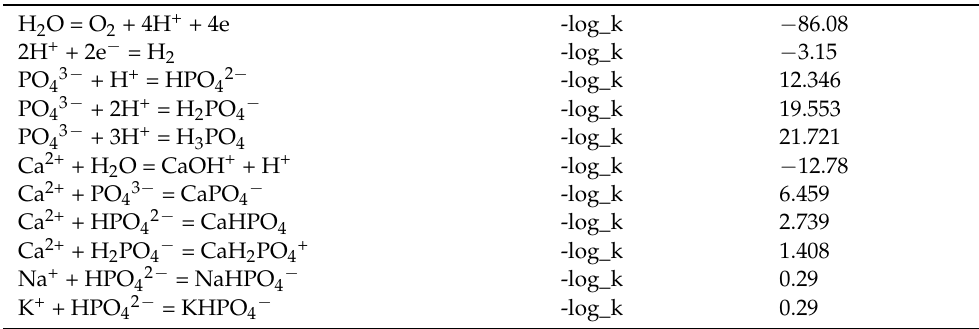
Table 1. Selected thermodynamic data for reactions in this system and their corresponding complexes. All data refer to a reference temperature of 298.15 K and standard state, i.e., a pressure of 0.1 MPa and, for aqueous species, infinite dilution [26,27].